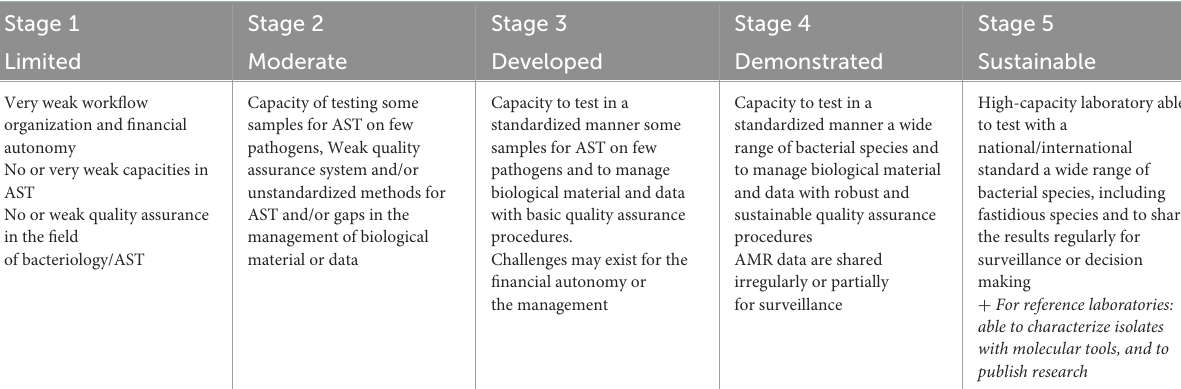
TABLE 4 Overview of the main characteristics of a laboratory according to the FAO-ATLASS PIP laboratory stage. Stage